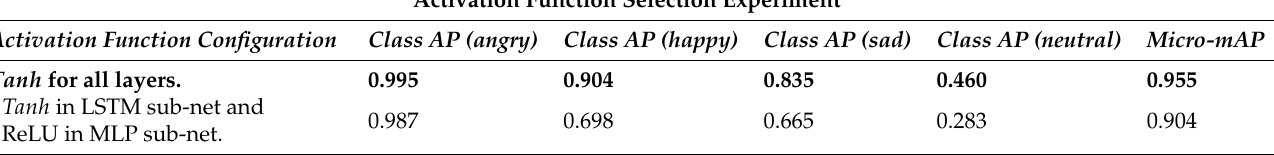
Table 3. Performance of the proposed method with different configurations of Tanh and ReLU activations.